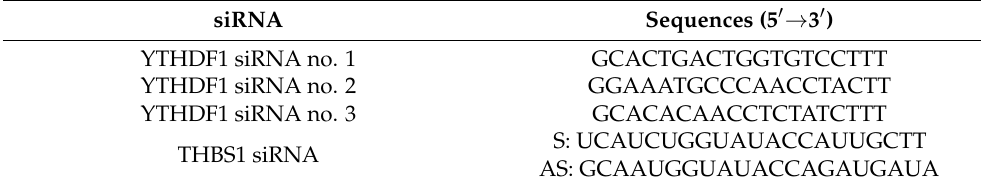
Table 1. siRNA sequences for transcription.